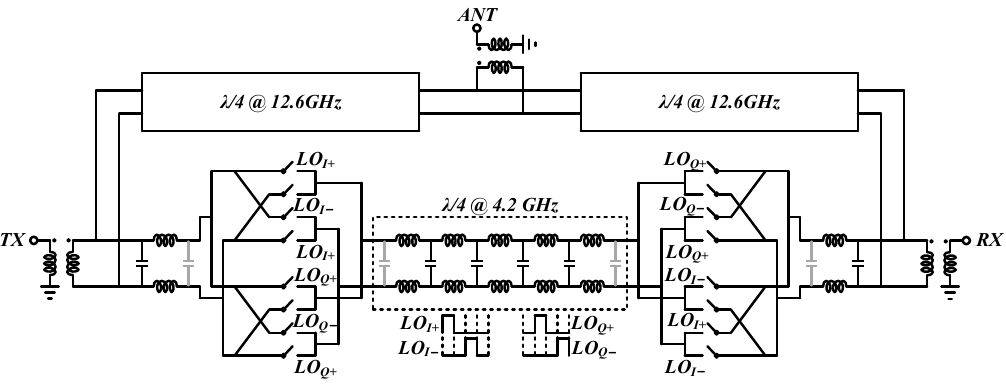
Figure 7. Proposed circulator using 25% duty-cycle clock signal.